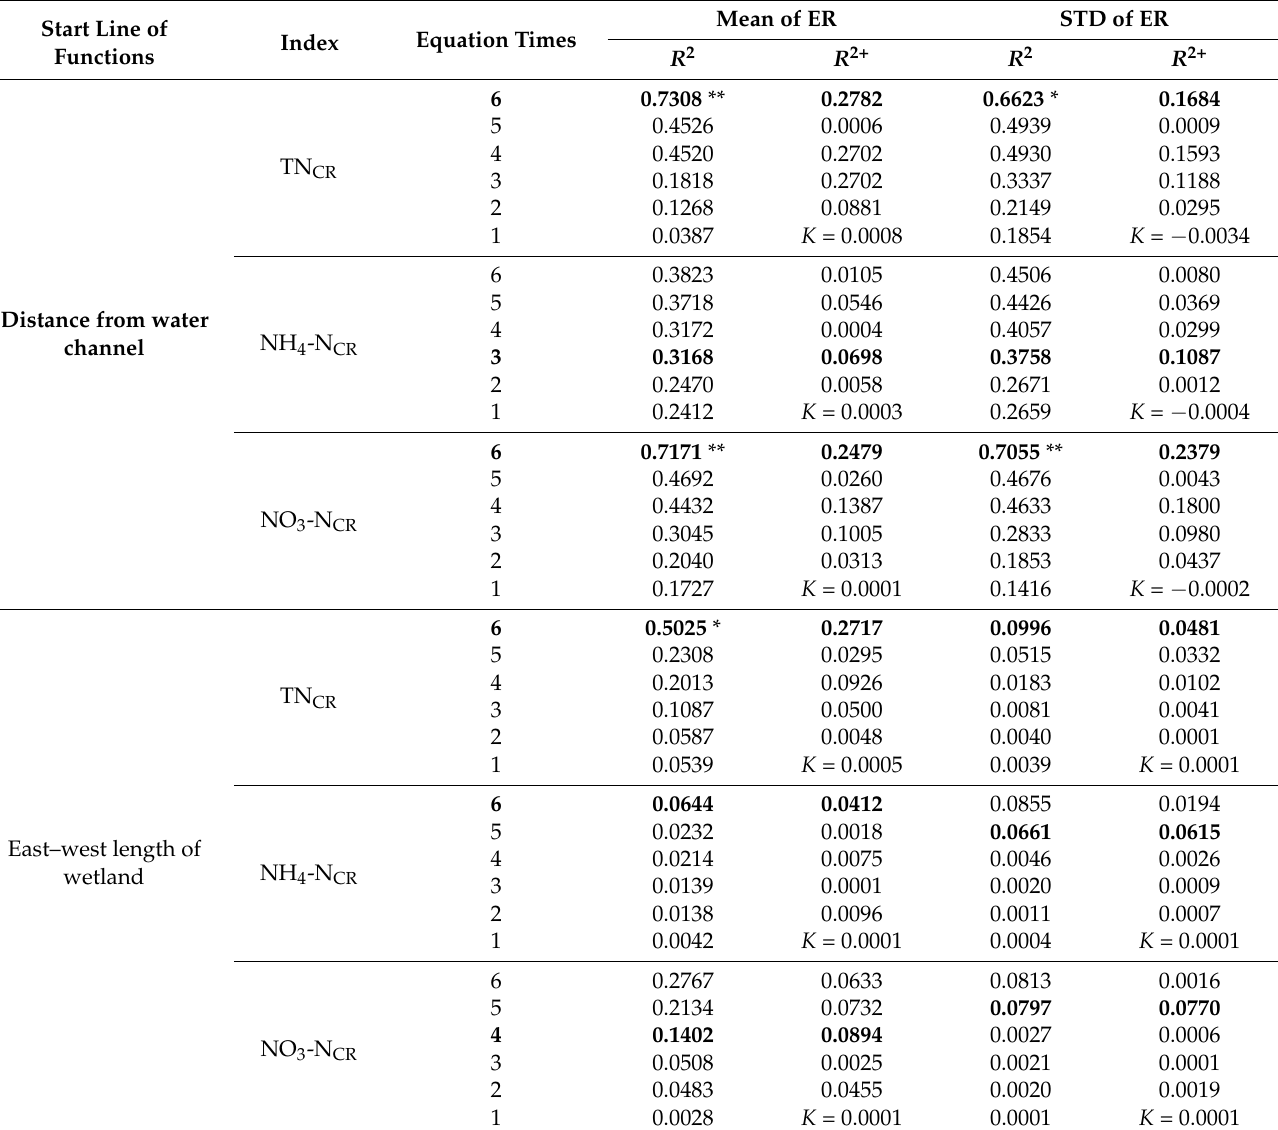
Table 5. R 2 and added R 2 values of the fitting function between the mean or STD of the ER (dependent variable) and the distance from the water channel (km) or east–west length of the wetland (km) (independent